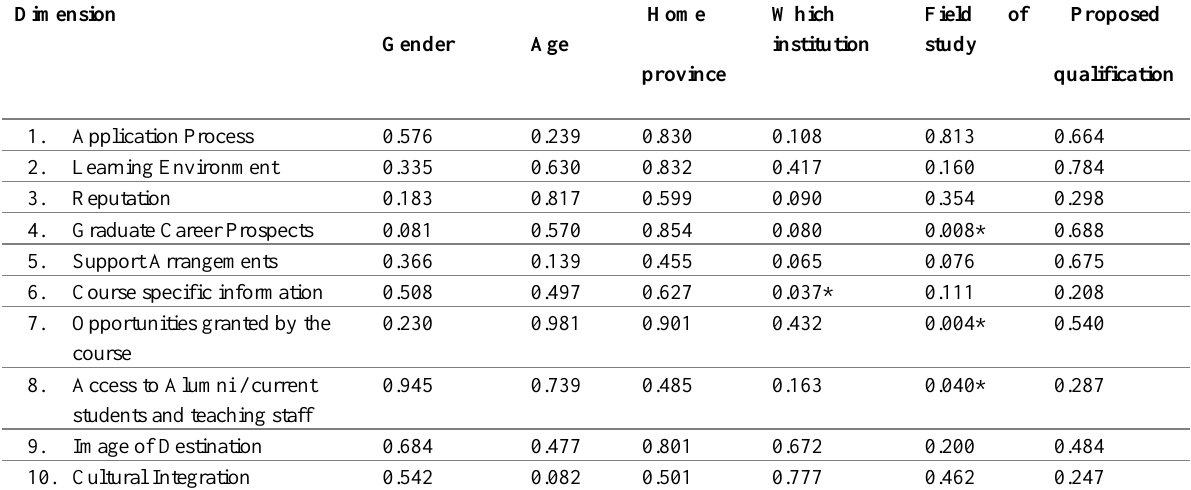
Table 3: Chi-squares test of demographic variables and information needs of postgraduate students Dimension